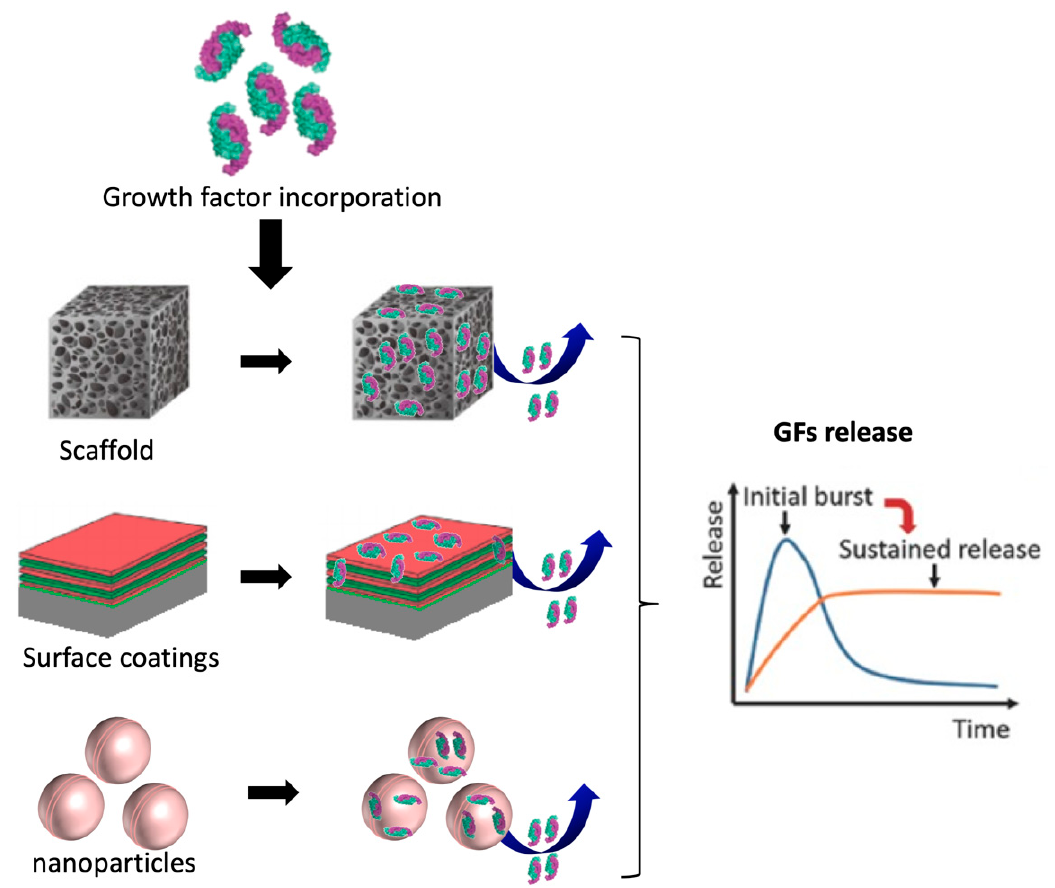
Figure 11. Materials (scaffolds, surface coatings, and nanoparticles) as DDSs used for efficient growth factor delivery in biomedical-engineering applications by promoting a sustained release. Adapted with permission from References [15,243,268]; published by Wiley, 2020 and 2016, and MDPI, 2011, respectively.